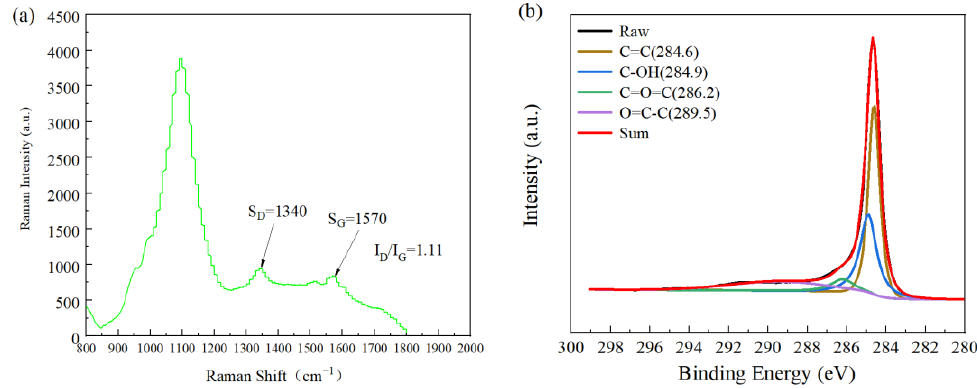
Figure 3. ( a ) Raman spectrum of the pretreated CNTs; ( b ) analysis of the C 1s peak position by CNTs XPS after mixed acid treatment.